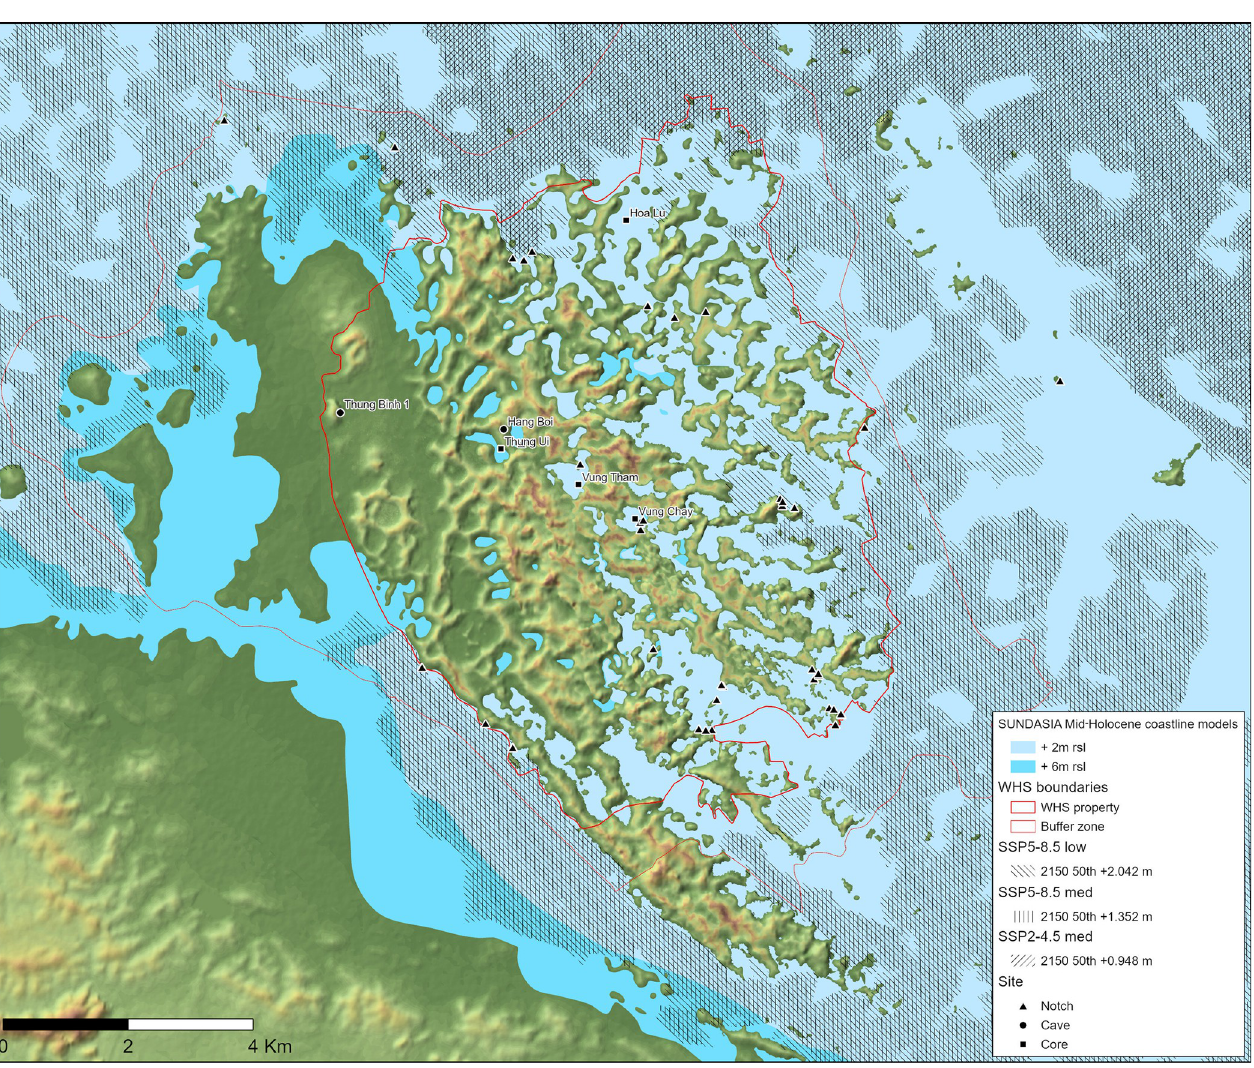
Fig 6. The Tr à ng An massif showing reconstructed min./max. elevation estimates for the local Mid-Holocene coastline [100] and projected SSP5–8.5 (low) SSP5–8.5 (med.) and SSP2–4.5 (med.) scenarios for the year 2150 (topographical base map derived from SRTM 1 Arc Sec DEM, courtesy of USGS / NASA: https://doi.org/10.5066/F71835S6). (Image: Thorsten